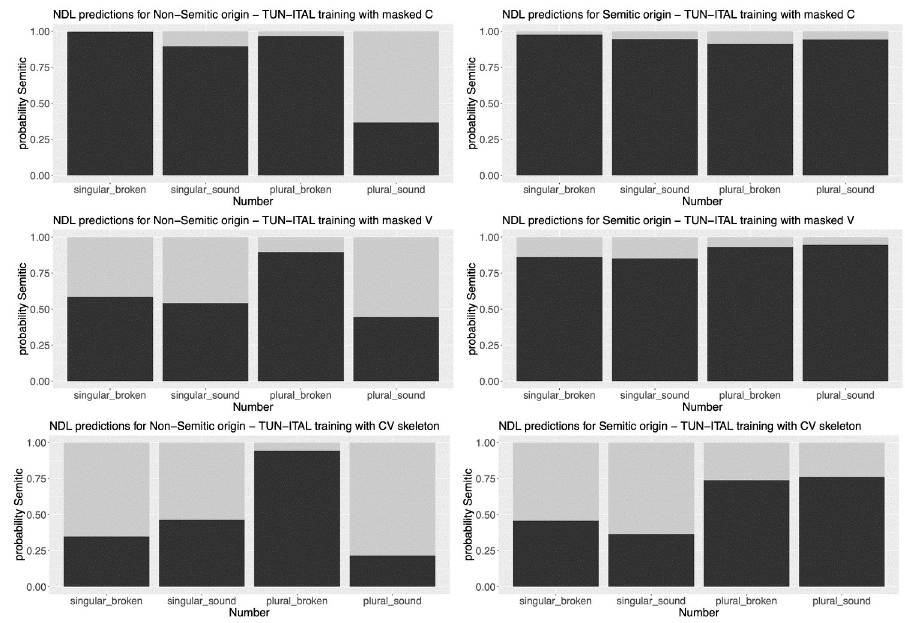
Fig 5. Classification probabilities (y-axes) for the Non-Semitic (left column) vs. Semitic group (right column) of Maltese nouns classified as Semitic by the models trained on Tunisian-Italian with masked consonants, masked vowels and CV skeleton